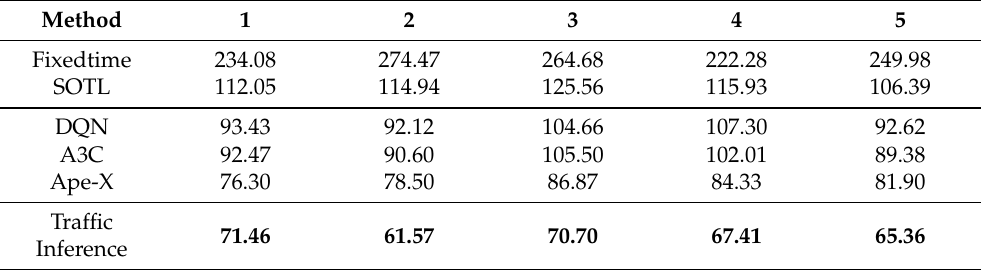
Table 1. Average travel time for the five intersections in Suzhou, in seconds. The bolded result is the optimal